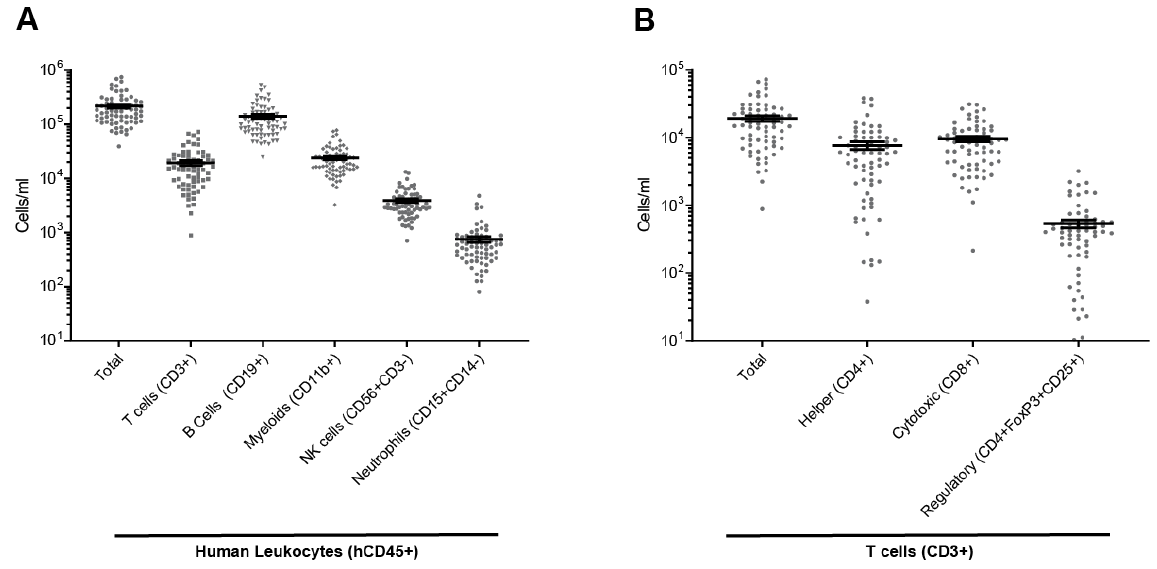
Figure 1. Human immune cell population in the peripheral blood of hu-mice. ( A ) Total human leu- kocytes (hCD45+), T cells (hCD3+), B cells (hCD19+), myeloid (hCD11b+), NK cells (hCD3-hCD56+), and neutrophils (CD145+CD14 − ) in the peripheral blood. ( B ) T cells including helper (CD4+), cyto- toxic (CD8+), and regulatory (CD4+FoxP3+CD25+) T cells in peripheral blood. Individual values ex- pressed as number of cells per ml, mean ± SEM.